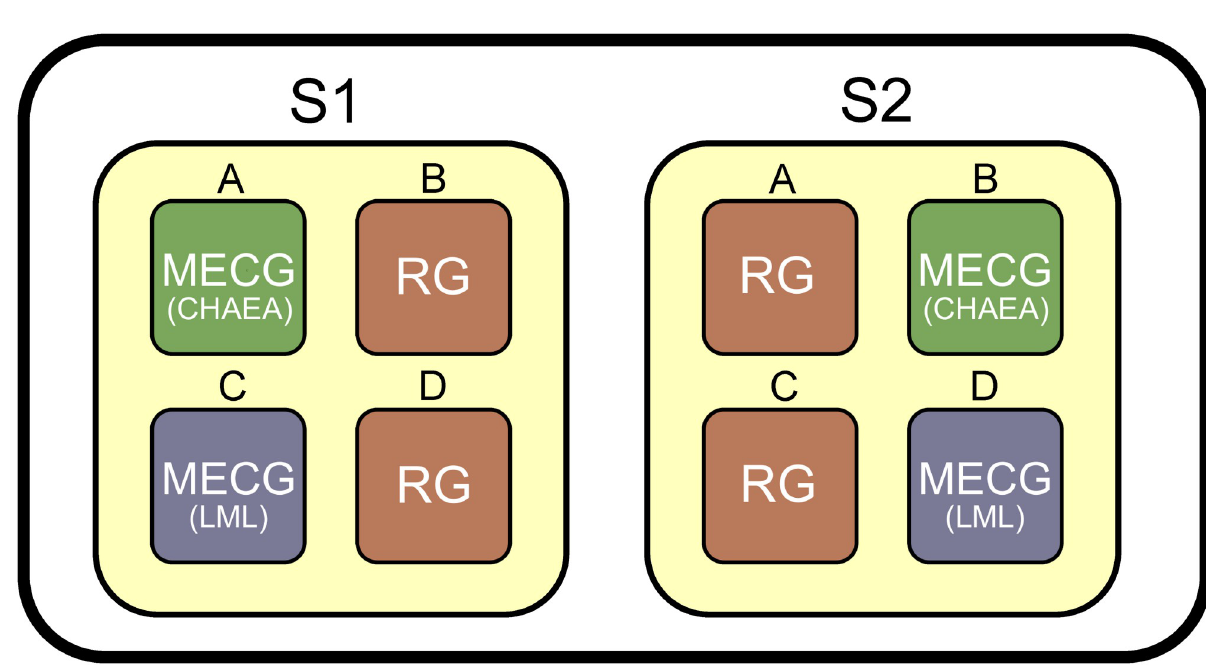
Fig 2. Experiment scheme. Students are divided into 4 different classrooms (A, B, C, D) within each subject (S1, S2). The same student is grouped randomly in one subject, and then grouped with our approach in the other subject (without their knowledge). Classrooms that are grouped randomly are shown in red (RG), and classrooms that are grouped with Minimum Entropy Collaborative Groupings (MECG) are shown in green (CHAEA) or blue (LML).